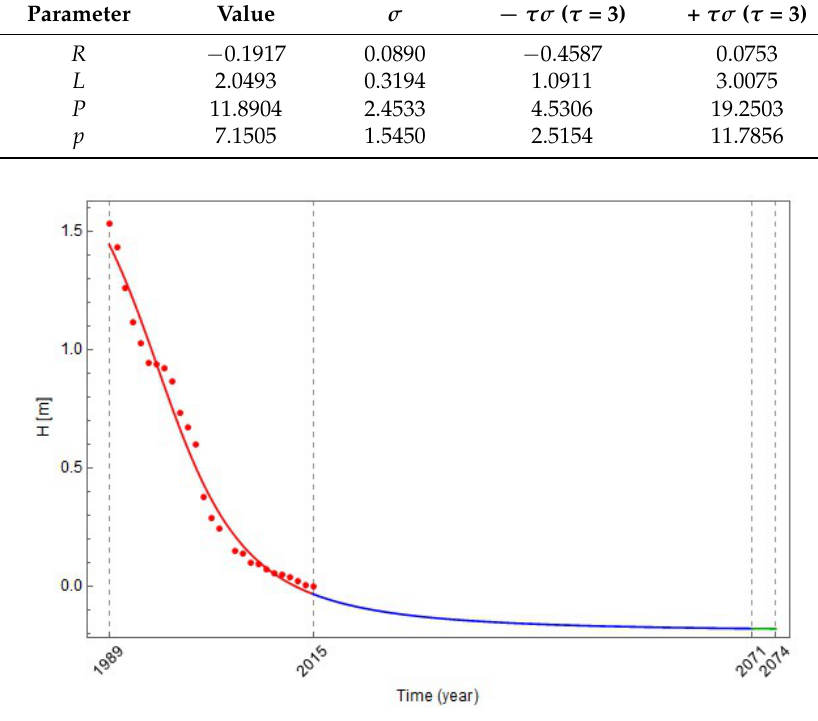
Figure 12. Graphical presentation of results from analysis of vertical displacement of point Ša7. Table 6. Results from the analysis of the vertical displacement of point X1-A1.